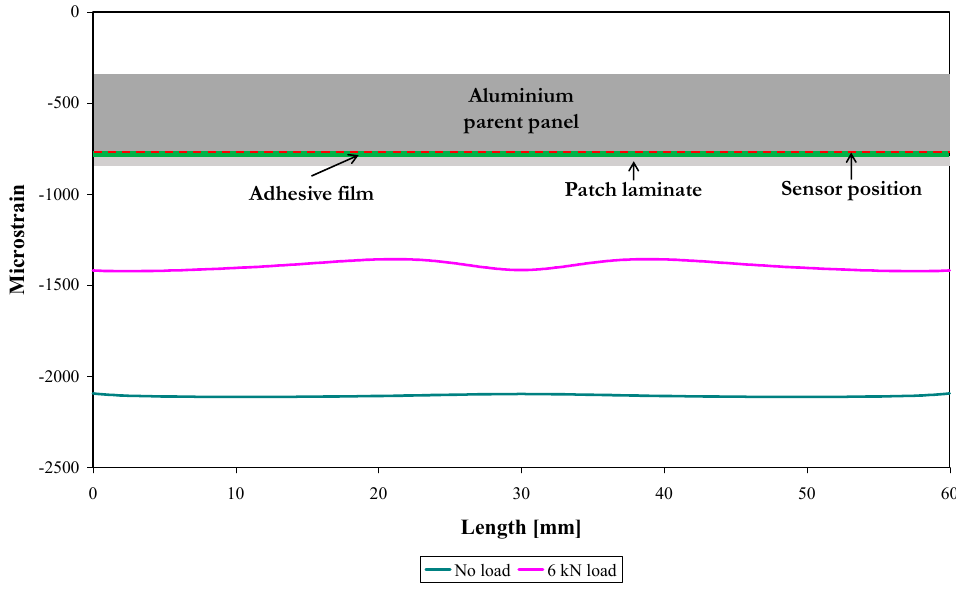
Table 4. SMF-28 ® optical properties.